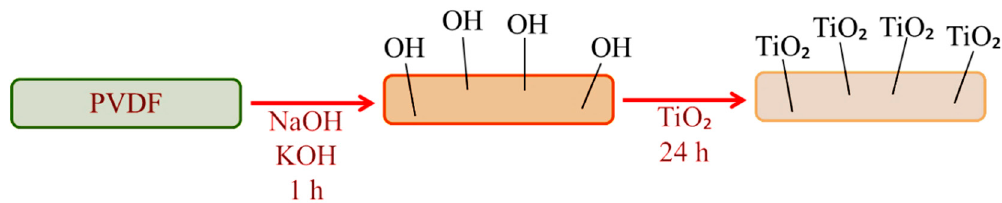
Figure 3. Schematic illustration of surface modification of PVDF nanofibrous membrane (inspired from [64]).